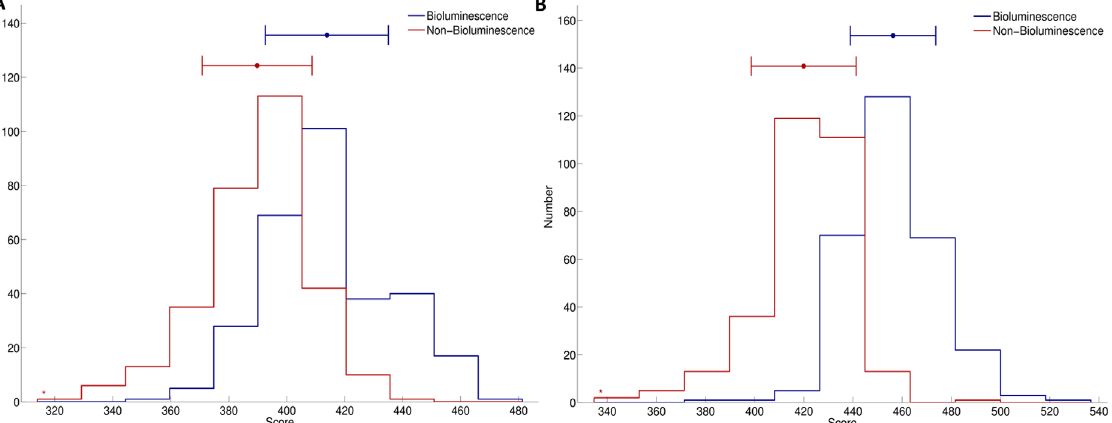
Figure 3. The histogram of propensity scores for BLPs and non-BLPs in the training dataset BLP-TRN. (A) Sequence scores before optimization (B) Optimized sequence scores.